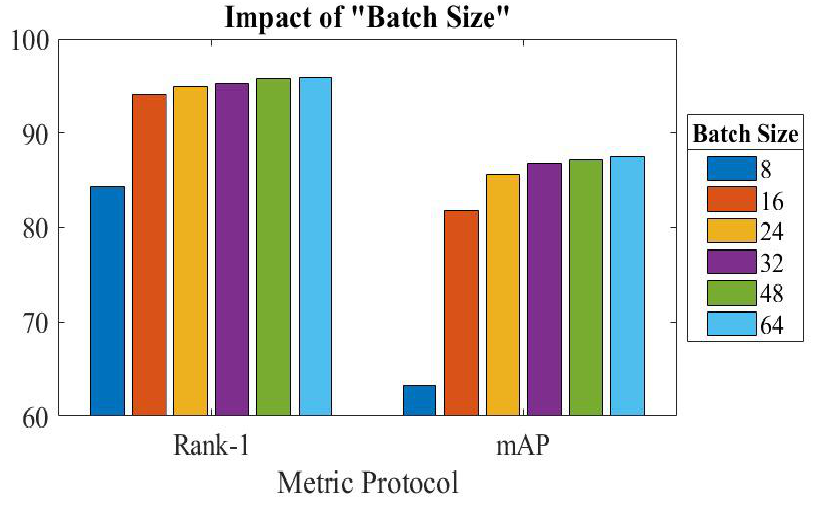
Figure 6. Effect of changing size of batch on Market-1501.